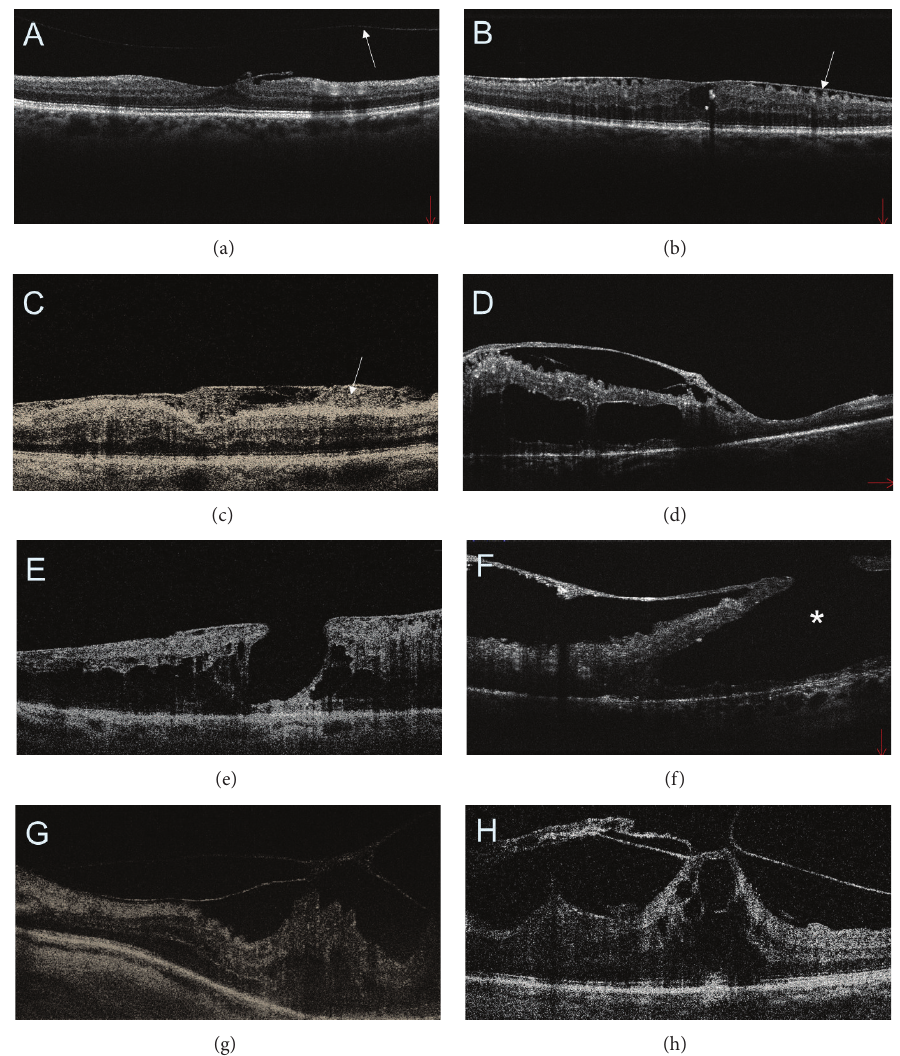
Figure 6: SDOCT cross-sectional images of the macular vitreoretinal interface abnormalities in diabetic retinopathy. (a) Posterior vitreous detachment (arrow) and a small, localized epiretinal membrane (ERM). (b) A thin ERM that is separated from the retinal surface in multiple areas causing distortion to the inner retinal layers and flattening of the central foveal depression. (c) ERM with an extensive fibrosis (arrow). (d) A thick and taut ERM inducing cystoid DME. (e) A thin ERM together with macular pseudohole. (f) Preretinal fibrosis causing the formation of lamellar macular hole (asterisk). (g) Vitreomacular traction. (h) An extensive macular traction with cystoid